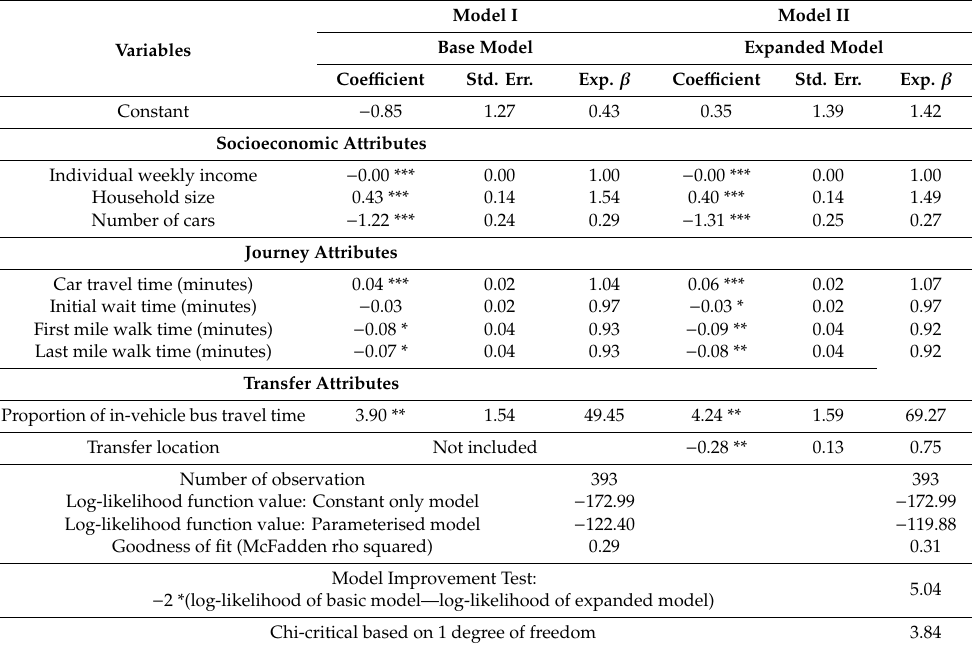
Table 2. Binomial logit model results: transfer location as an ordinal